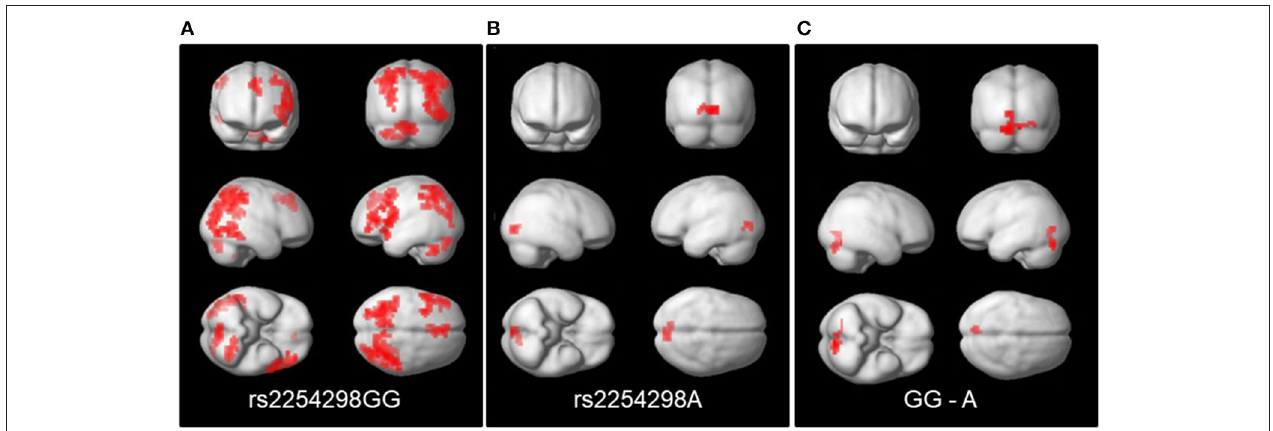
FIGURE 4 | Regions showing connectivity to the posterior cingulate cortex seed (MNI − 8, − 56, 26). On the left panel (A) , the GG subjects showed positive connectivity between the posterior cingulate cortex and regions in bilateral parietal, lingual, cerebellar, and the left middle frontal gyrus and dorsal anterior cingulate. In the center (B) , the A subjects showed negative connectivity with the lingual lobe. On the right (C) , the comparison of the connectivity in the GG-A subjects resulted in a single cluster in the cerebellum and lingual